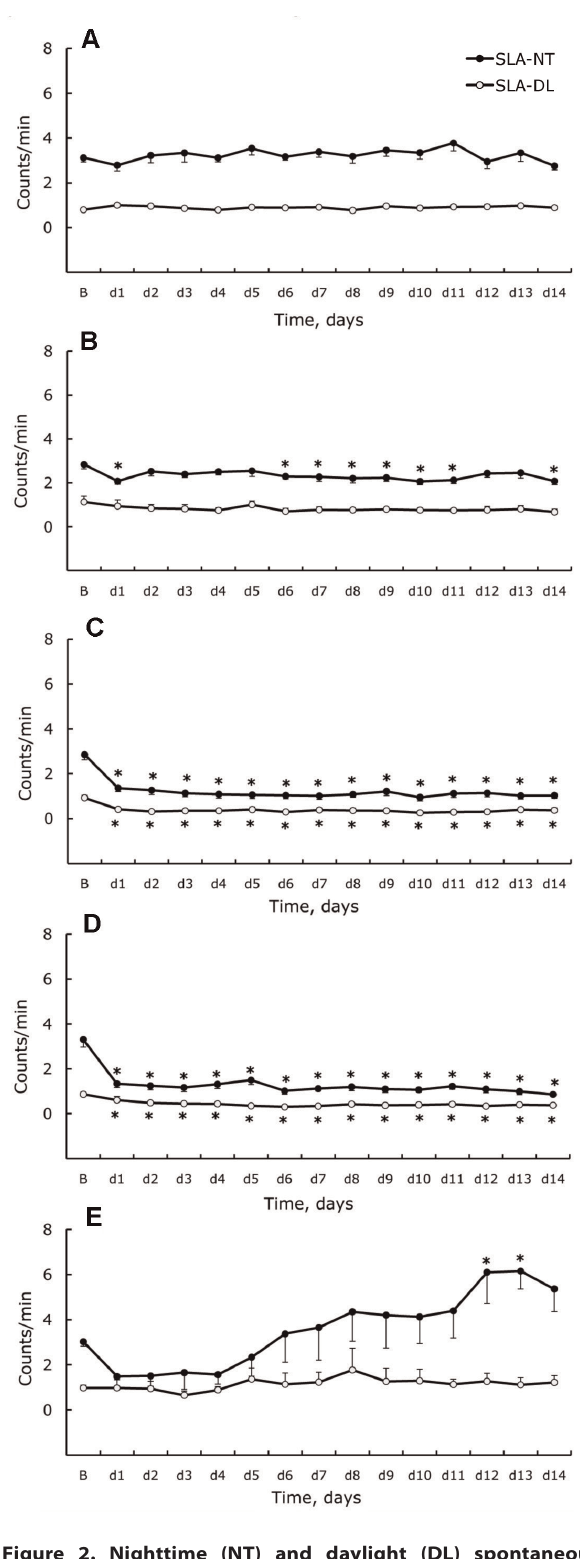
Figure 2. Nighttime (NT) and daylight (DL) spontaneous locomotor activity. Activity was measured in standard cages (BL) and during 14 days (d1–d14) for control ( A ), isolated-control ( B ), isolated ( C ), attached ( D ), and unloaded ( E ) rats. Data are given as a mean 6 SEM. *- P , 0.05 versus basal level (BL).